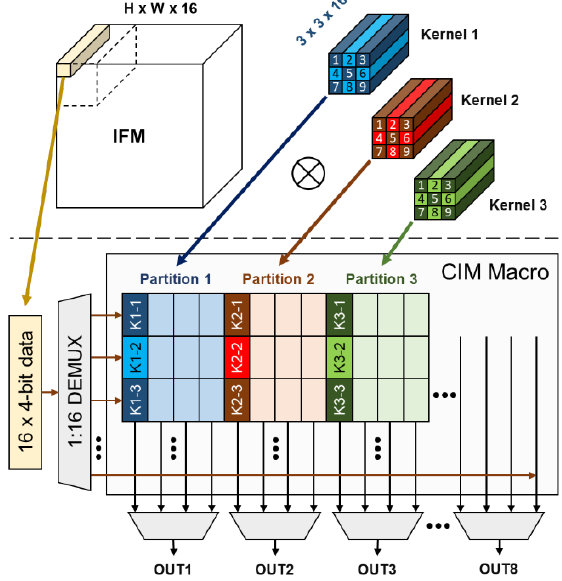
Figure 6. Example of an IFM convolving with three 3 × 3 × 16 kernels and mapping these kernels onto different CIM partitions.